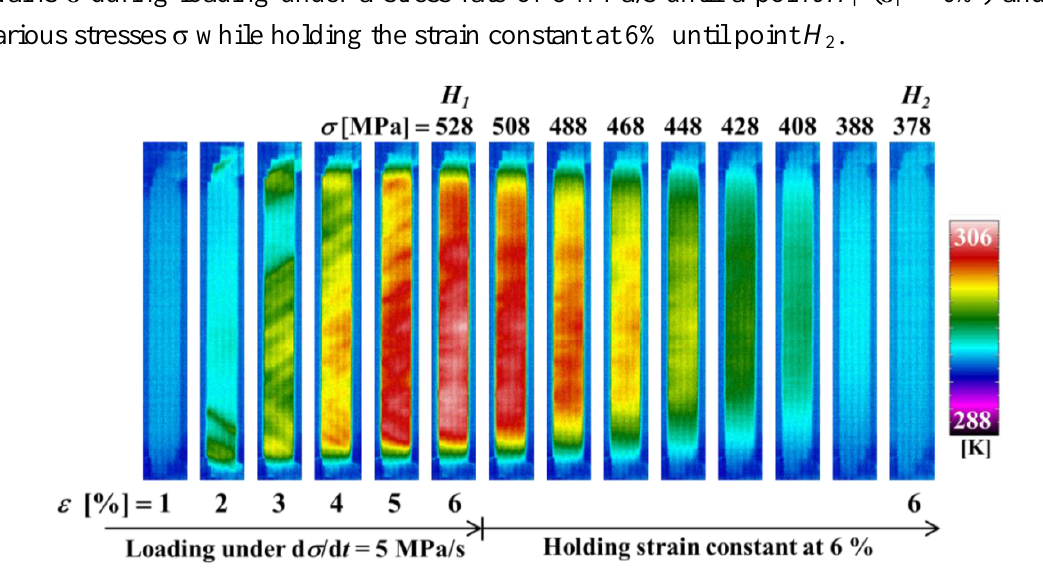
(ε = 6%) and at 1 1 2